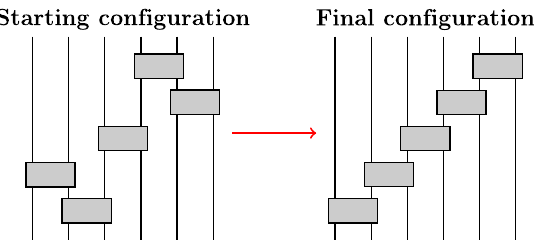
FIG. 3. Transforming the initial configuration M ¼ M 4 ; 5 × M M M M 5 ; 6 3 ; 4 1 ; 2 2 ; 3 to the final S configuration preserves the spectrum of M . For OBC, any configuration can be transformed to